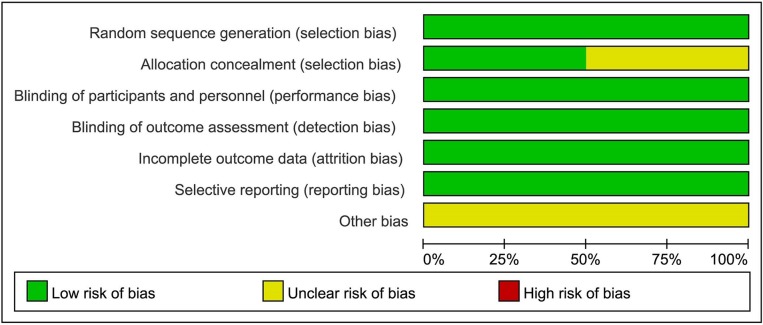
Risk of bias graph.